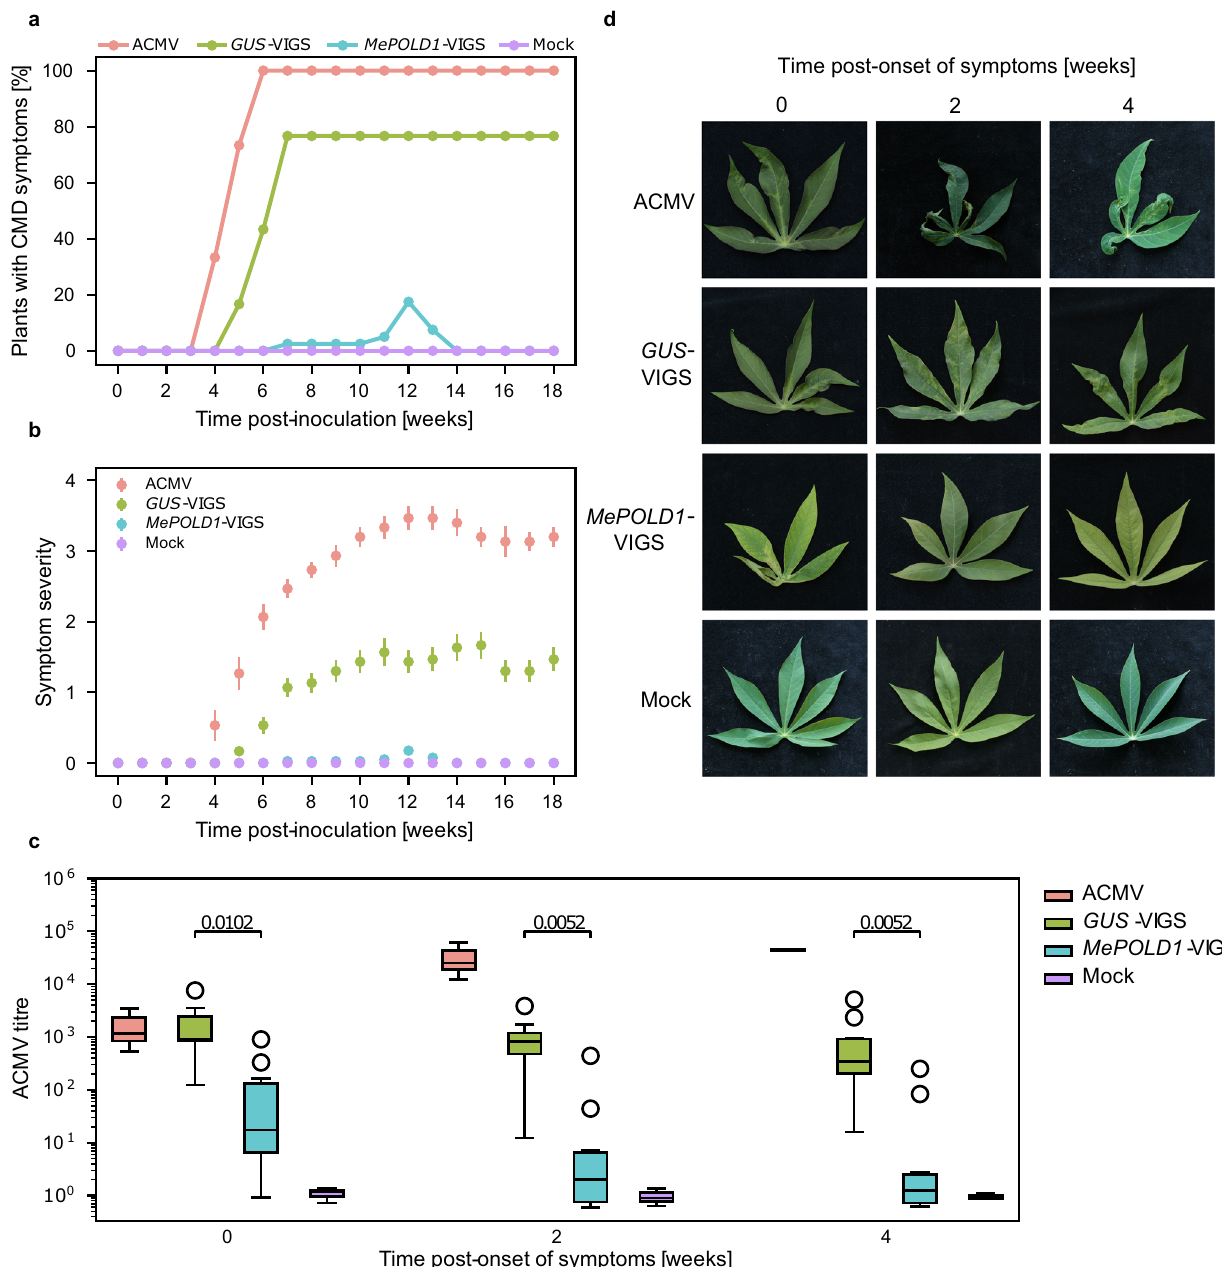
Fig. 3 VIGS targeting of MePOLD1 . CMD-susceptible cassava 60444 recovers from ACMV infection when MePOLD1 is downregulated by VIGS. a Percentage of symptomatic 60444 plants and ( b ) CMD symptom severity according to Fauquet and Fargette, 1990 56 18 weeks post-inoculation: ACMV ( n = 15), GUS -VIGS ( n = 30), MePOLD1 -VIGS ( n = 40), and Mock ( n = 15). Bars show standard error. c Quanti fi cation of ACMV titre post-onset of